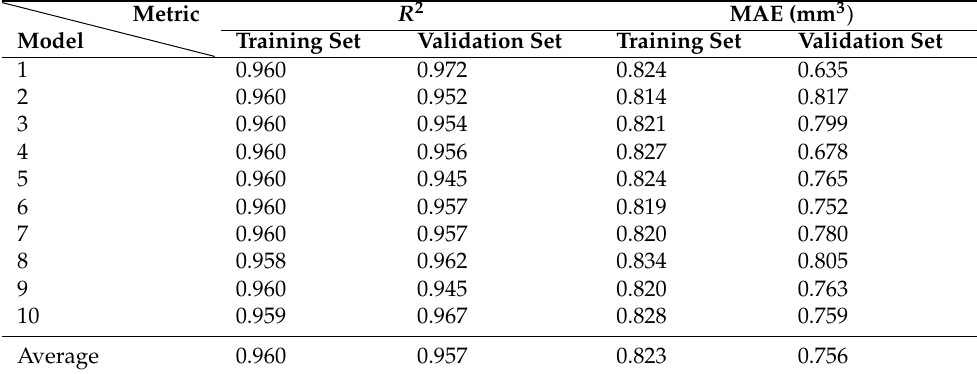
Table 6. Performance of KRR model on different training and validation